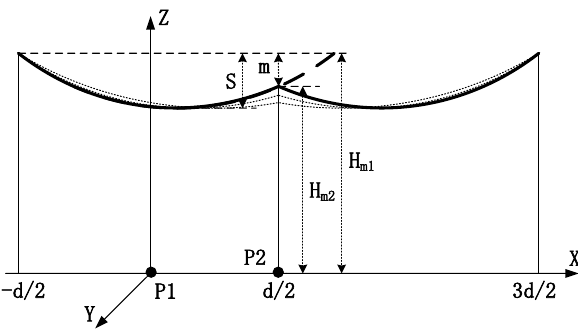
Figure 14. Schematic diagram of transfer cable configuration.